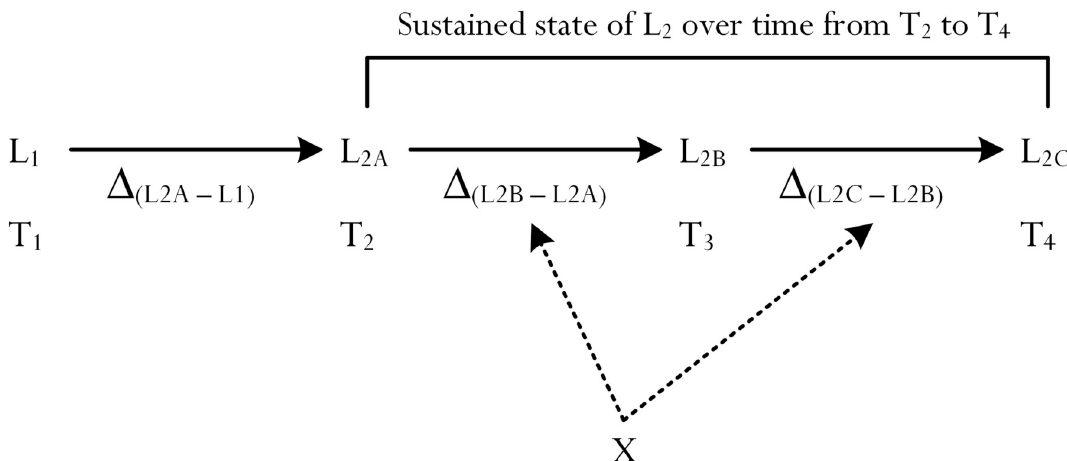
Fig 4. Conceptualization of measurement and assessment of L 2 . A conceptualization of a methodological design, which may consist of multiple time points: T 1 , T 2 , ... , T n , where n = 1, 2, ... .. In this conceptualization for consideration, L 1 is measured and assessed at T 1 whereas L 2 is measured and assessed at T 2 (i.e., L 2A ) and beyond. A methodological design for usage is more explanatory when it encompasses both non-experimental (e.g., the use of a Likert measure at, say, T 1 ) and experimental (e.g., an intervention, denoted as ‘X’, in between T 2 and T 3 or at T 3